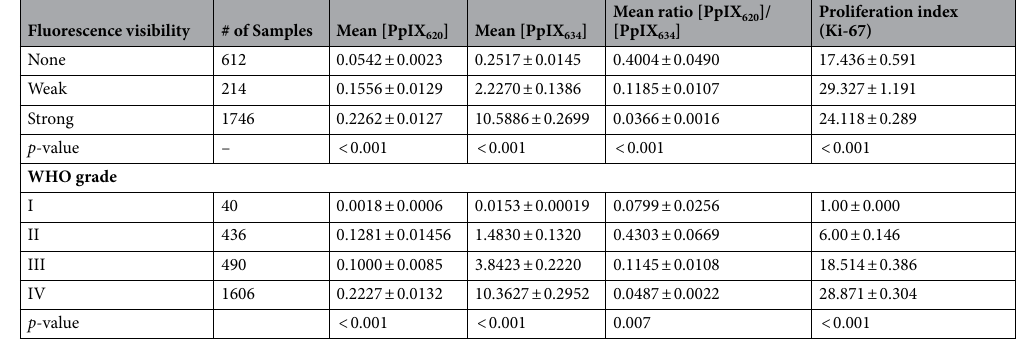
Table 2. Tissue overview, categorized by fluorescence visibility and WHO grade (I, II = LGG; III, IV = HGG). The given uncertainty is the standard error of the mean. Units are a.u.